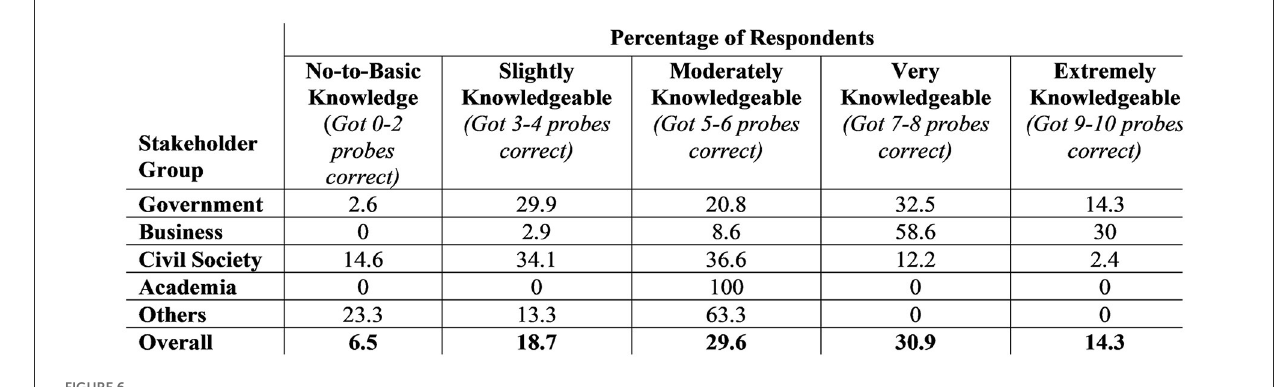
FIGURE6 Respondents’ actual CE